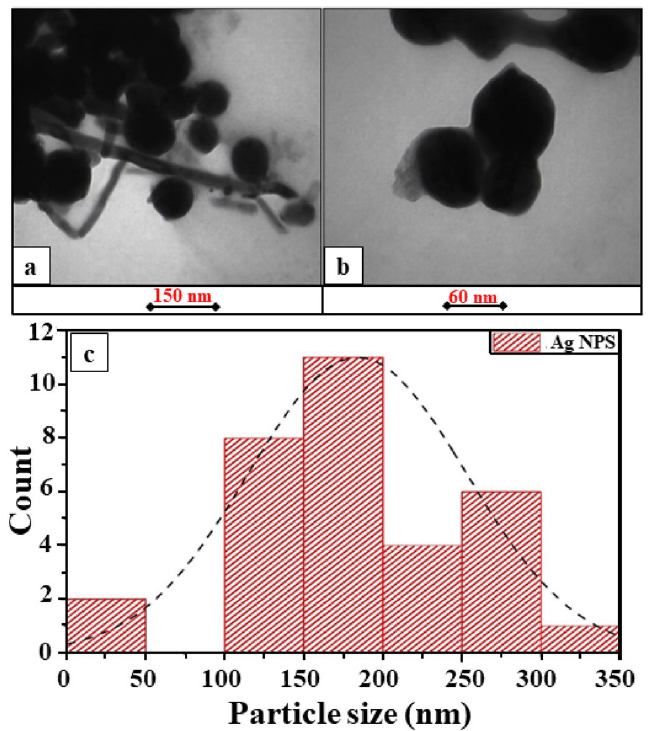
Figure 4. TEM Images of ( a , b ) Ag/AgO NPs prepared by biosynthesis method with different magnification, and ( c ) the histogram size distribution.